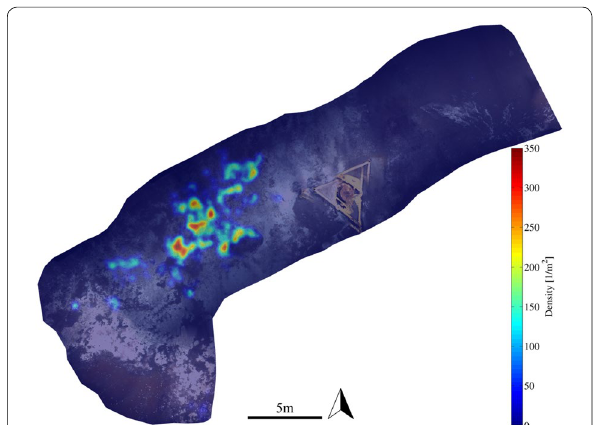
Fig. 6 Population density map of S. crosnieri at chimney C0014G. The density map of the S. crosnieri squat lobsters is overlaid on a top view of the 3D reconstruction of the area around the C0014G artificial hydrothermal vent